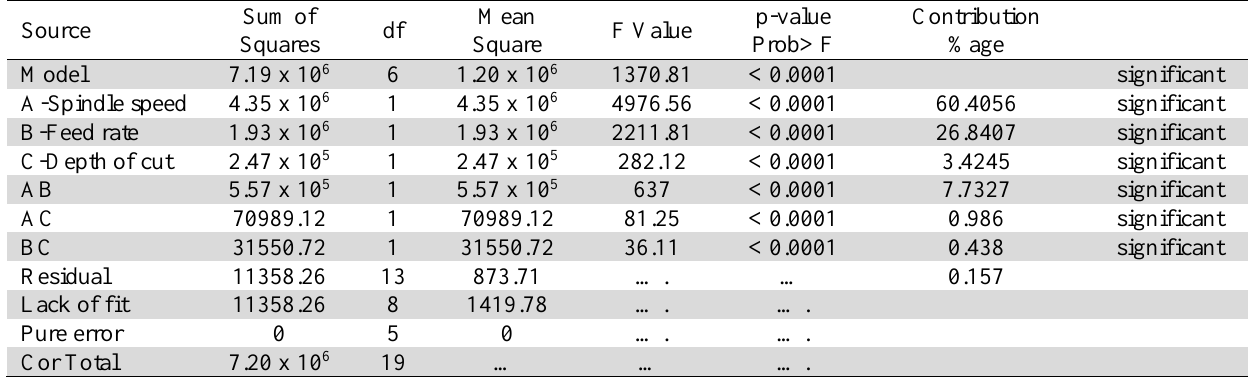
Analysis of variance table for MRR after backward